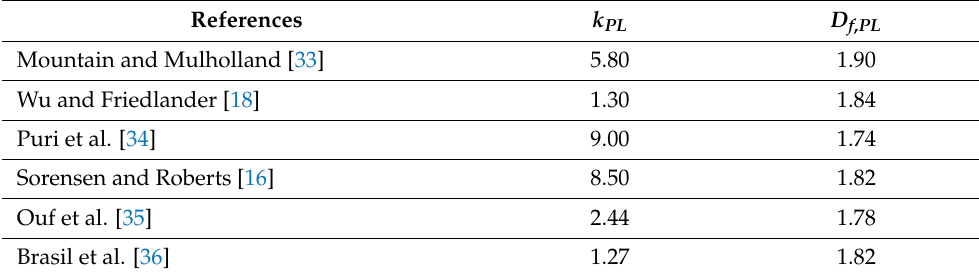
Table 1. Values of k PL and D f , PL from previous